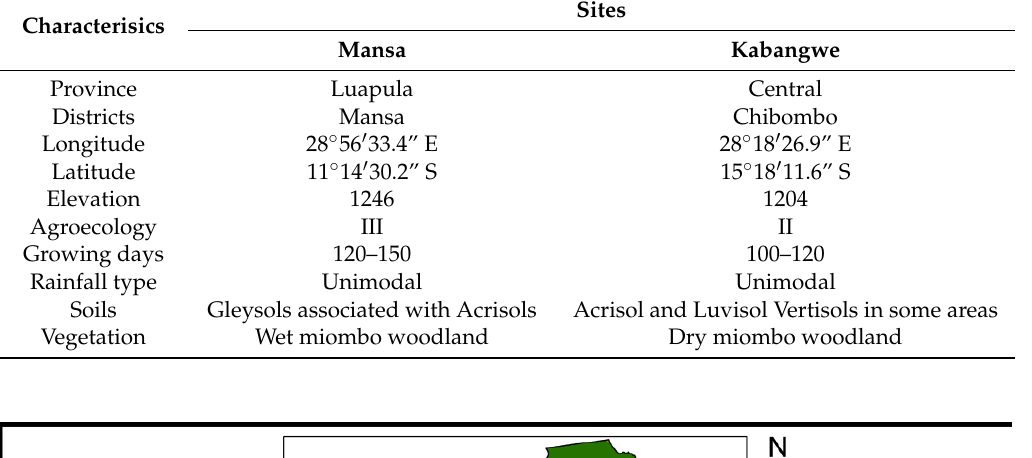
Table 1. Characteristics of the study sites [24–27]. Table 1 . Characteristics of the study sites [24–27].